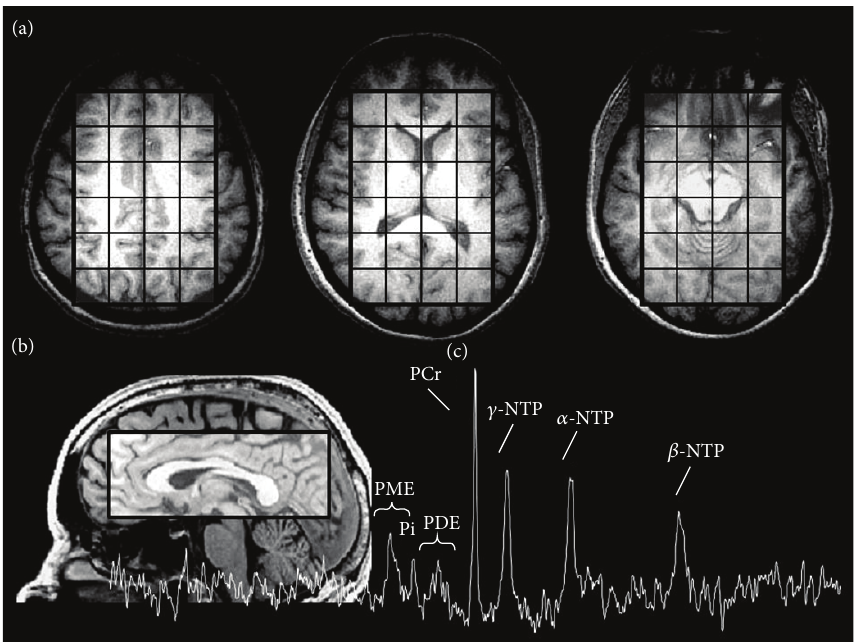
Figure 1: (a) Three representative axial brain slices illustrating voxel coverage for global whole brain [31] P MRS assessment, (b) illustrating a sagittal view of the voxelization of subcortical areas, and (c) a resultant [31] P MRS imaging spectra indicating phosphorus-containing